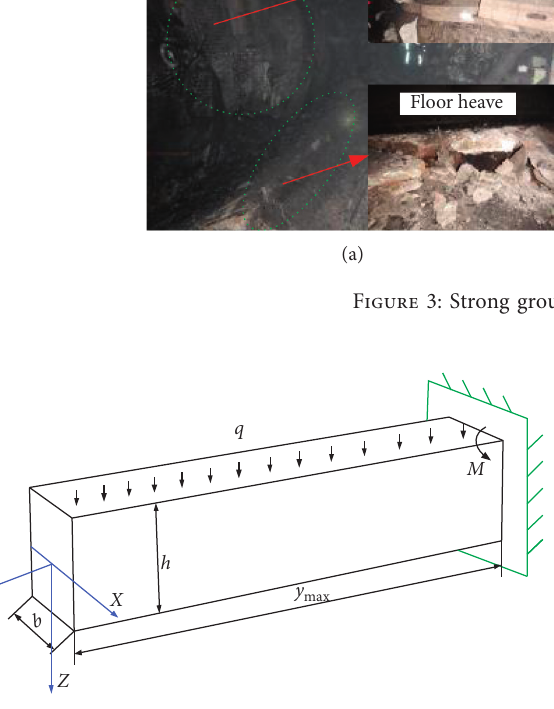
Figure 4: Mechanical model of a cantilever beam pure